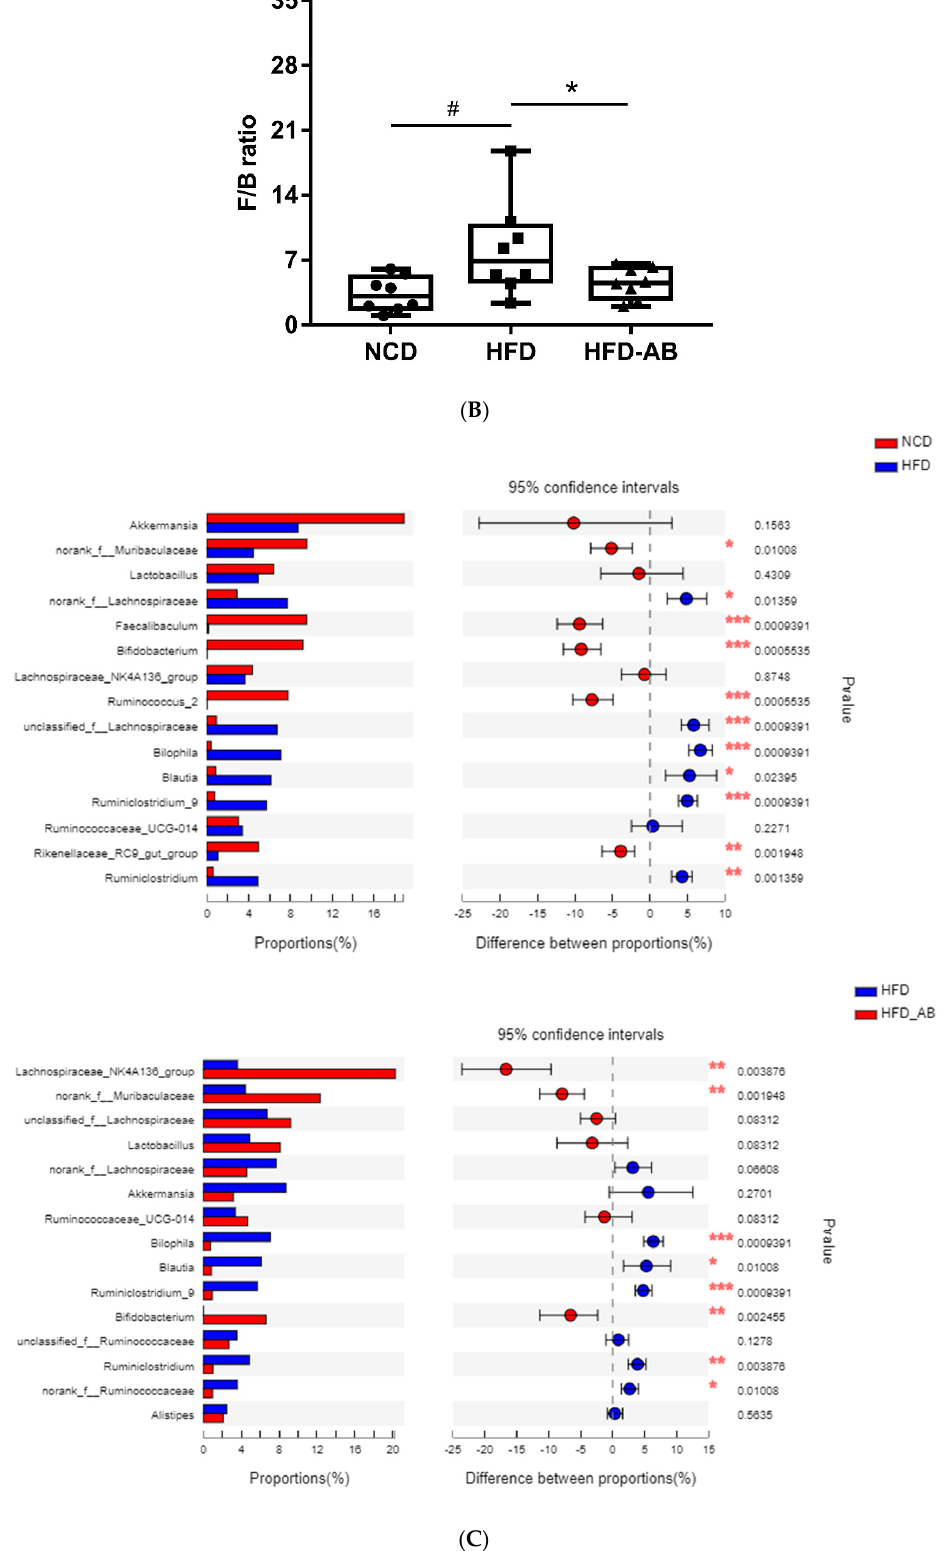
Figure 6. Adzuki bean supplementation modulated gut microbiota composition (n = 8 per group). ( A ) The abundances of gut microbiota at the phylum level, ( B ) the F/B ratio, and ( C ) mean proportions of key genera in different groups. # p < 0.05, HFD compared with NCD mice. * p < 0.05, HFD-AB compared with HFD mice (Figure 6B). * p < 0.05, ** p < 0.01, *** p < 0.001 (Figure 6C). NCD, normal control diet; HFD, high-fat diet; HFD-AB, high-fat diet supplemented with adzuki bean.